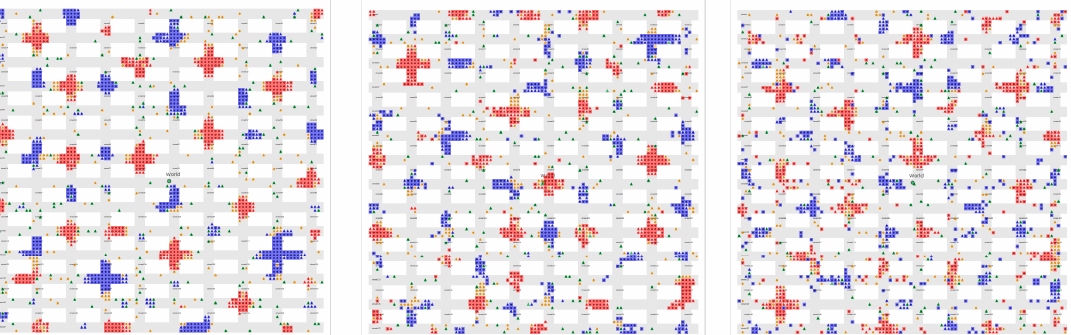
Figure 11. World consisting of mobility constraints (streets), 400/400 class a/b agents (blue and red squares) and digital twins (triangles) with different model parameters. ( Left ) Only social-driven mobility and clustering. ( Middle ) Social and traffic driven mobility with low attraction of the destination. ( Right ) Social and traffic driven mobility with high attraction of the destination.